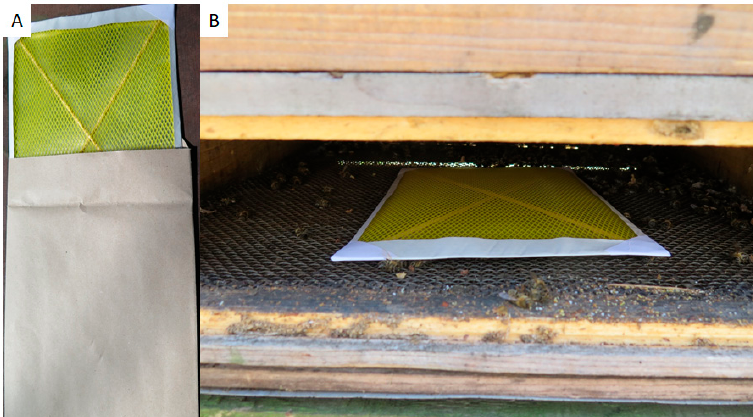
Figure 1. Paper sheets for hive debris collection ( A ); installed in the hive bottom board ( B ).